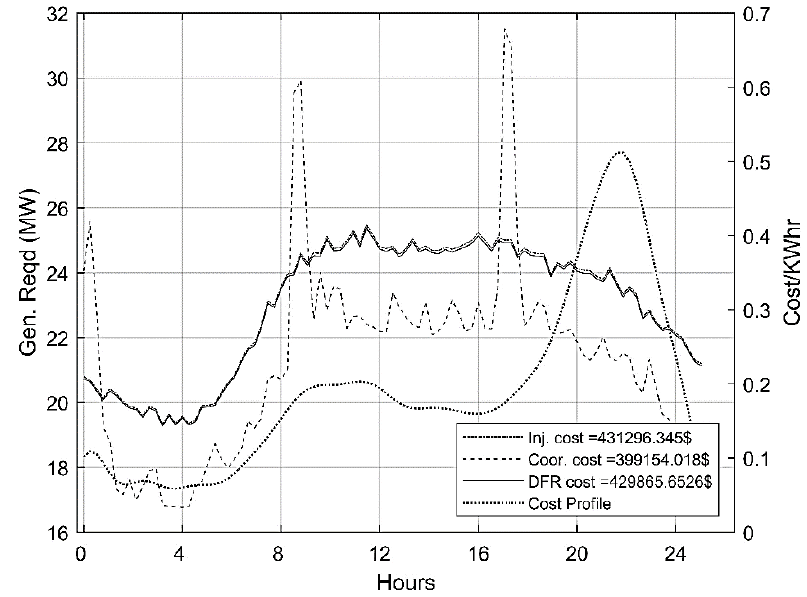
Figure 11. Generation requirements and cost comparison for three techniques.